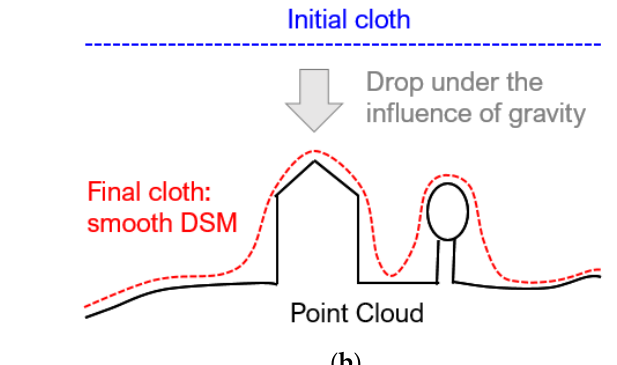
Figure 10. Sample digital surface model (DSM) generated using ( a ) 90th percentile, ( b ) cloth simulation, and ( c ) average height. A selected area for DSM comparison is shown in the black box. ( d ) Side view of the selected area showing the point cloud and generated DSMs using different approaches.